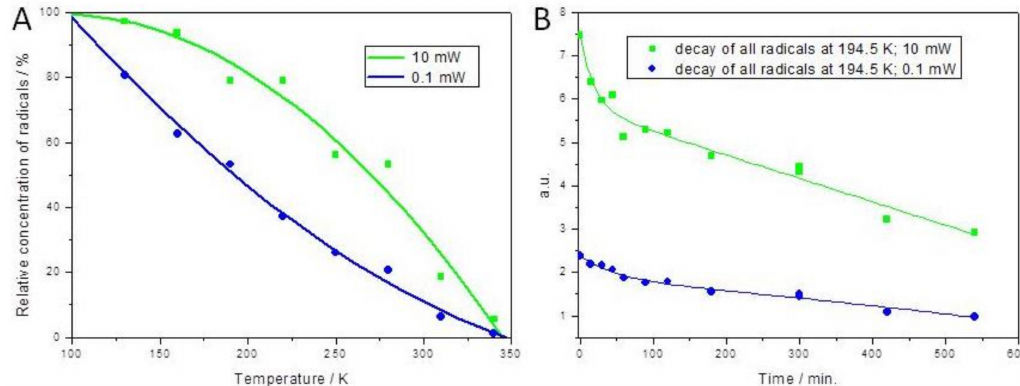
Figure 4. ( A ) The relative concentration of all radicals during annealing, calculated by double integration of spectra presented in Figure 3. The peroxyl radical signal is pronounced in the higher microwave power, as compared to alkyl radicals (pronouncedly seen in lower microwave power). ( B ) The decay of radicals in collagen irradiated and stored at the dry ice temperature calculated by double integration of the experimental spectra depicted in Figure 3.